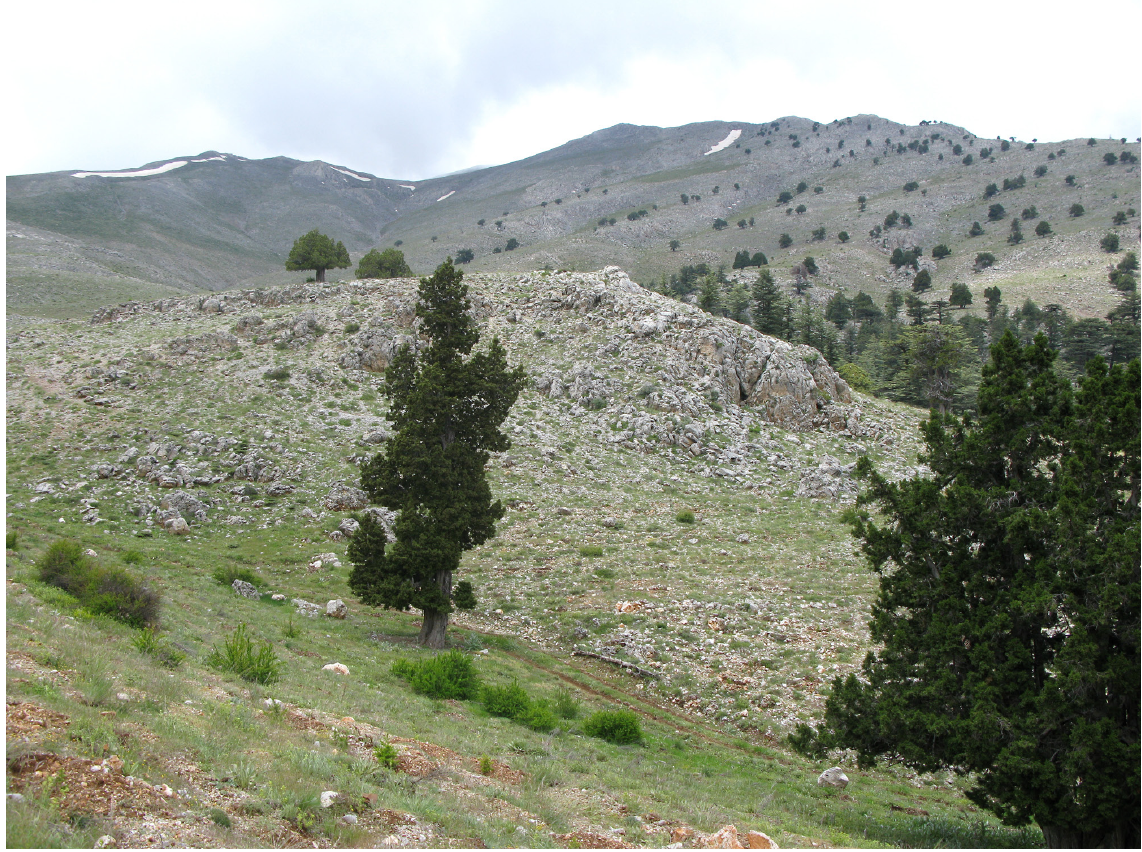
Fig. 3. Habitat of Dichorrhinus geiseri sp. nov. in May in Ören, Turkey at 2421 m. a. s. l. (photo: P.